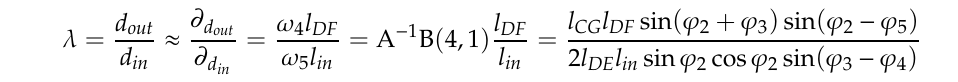
Table 2. Material properties of the microgripper.